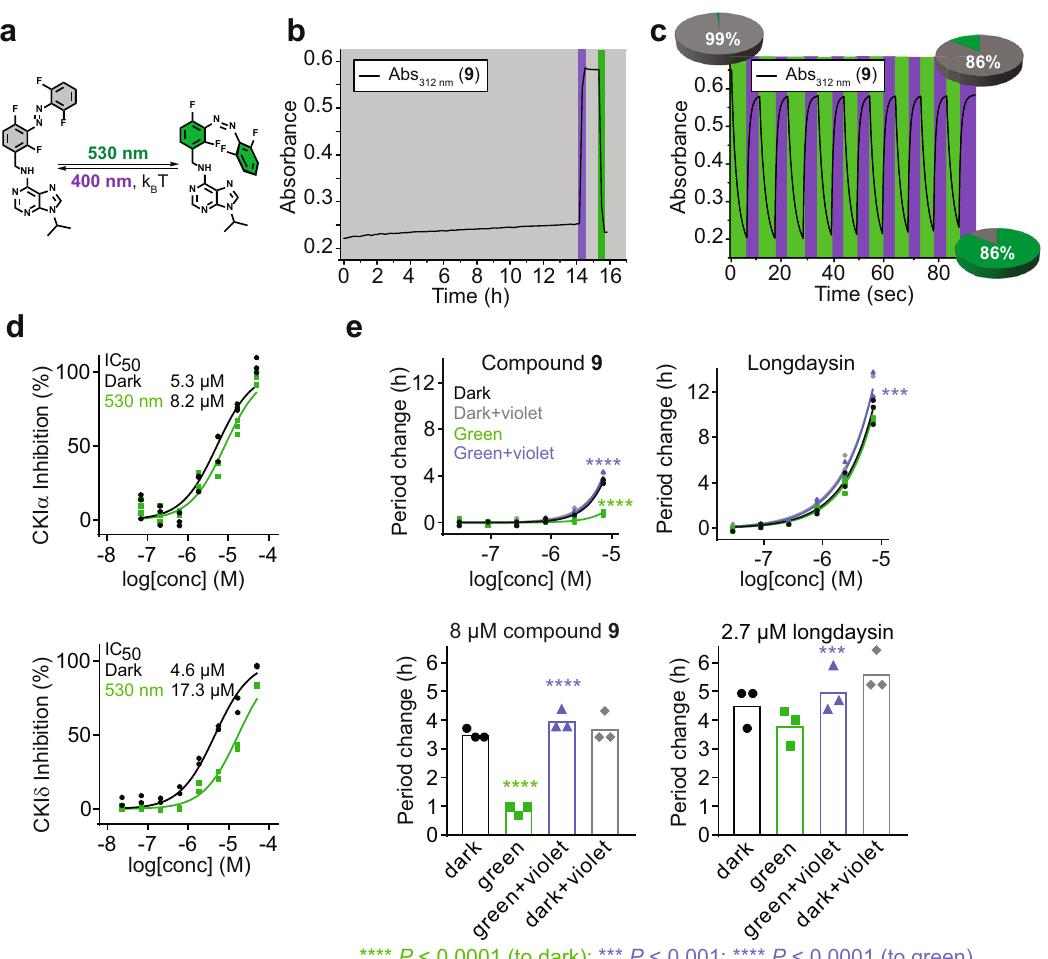
Fig. 4 Photochemical and biological evaluation of modulator 9. a Photoisomerization scheme using green light ( λ max = 530 nm) for trans -to- cis and violet light ( λ max = 400 nm) for back-isomerization. b Thermal half-live of modi fi er 9 in cell culture medium ( t 1/2 > 50 h, 35 °C, 40 µ M). Upon reaching PSS distribution with green light, thermal back-isomerization was followed in the dark for 14 h (gray background). After this period, violet light was applied (violet rectangle) for 8 min to con fi rm the presence of the remaining cis -isomer and estimate cis -to- trans ratio. Green light allowed for switching to the cis - isomer once again (green rectangle), showing that in situ isomerization is possible. c Reversible photochromism in cell culture medium followed at 312 nm absorbance. Almost no fatigue was observed after nine repetitions (cell culture medium, 40 µ M, 35 °C) of irradiation with violet and green light. d Light- modulation of the CKI α and CKI δ inhibition. The trans -isomer (dark, shown in black) shows higher potency than the cis -enriched mixture (green light, shown in green). e Circadian period modulation in U2OS cells with light. The thermally adapted sample is shown in black (dark), irradiated with green light in vitro ( pre-incubation, shown in green), with violet light in cellulo (post-incubation, shown in gray), and with green light in vitro followed by violet light in cellulo in purple. The control experiment with longdaysin is also shown. Luminescence rhythm pro fi les and data for DMSO-treated cells are shown in Supplementary Figs. 25 and 26, respectively. Luminescence is given in arbitrary units. n = 3 biologically independent samples for the CKI α enzymatic assay ( d ), n = 2 biologically independent samples for the CKI δ enzymatic assay ( d ), and n = 3 biologically independent samples for the cellular assay ( e ). Two- way ANOVA followed by a Sidak ’ s multiple comparisons test ( e , top panels) or one-way ANOVA followed by a Tukey ’ s multiple comparisons test ( e , bottom panels) was used for statistical analysis. P value is shown in the fi for trans - 9 was lower than for cis - 9 in case of CK1 δ complex (Supplementary Fig. 38b), corroborating the IC 50 values deter- mined for these compounds in vitro (Fig. 4d).